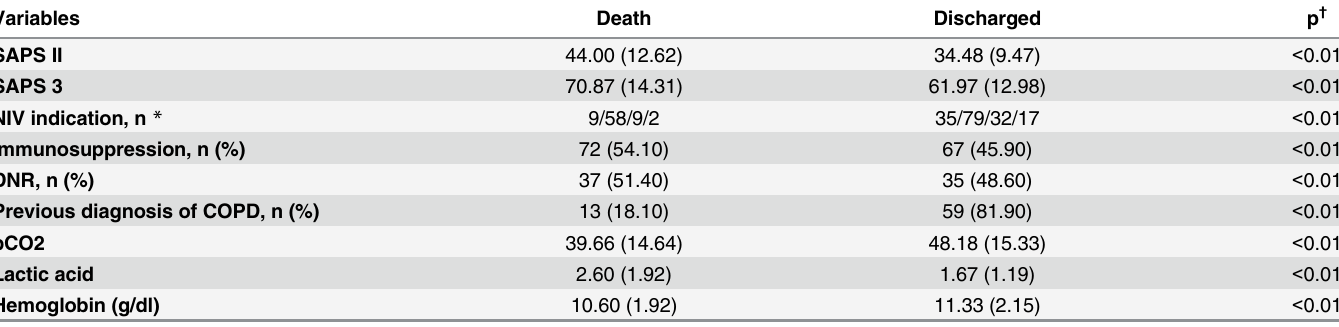
Table 4. Univariate analysis of new variables for NIV mortality prediction.